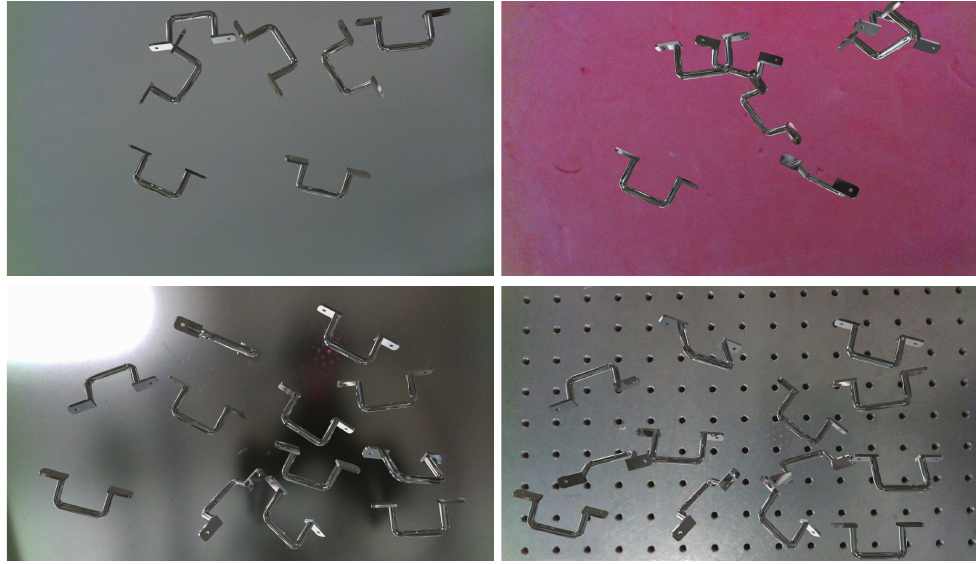
Figure 3. The generated synthetic images with different backgrounds and